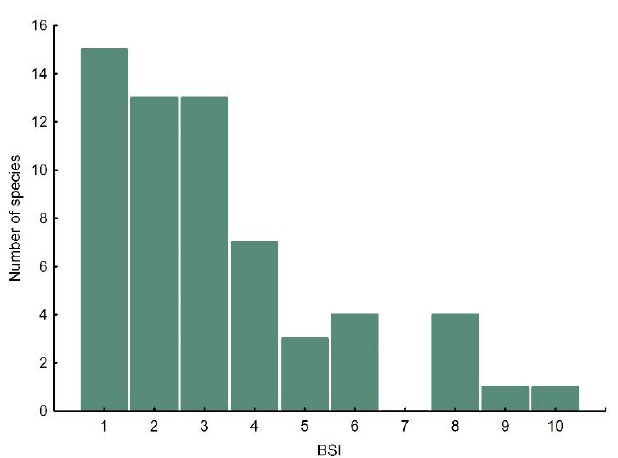
Figure 2. Frequency distribution of the biomic specialisation index (BSI) in the Falconidae species.